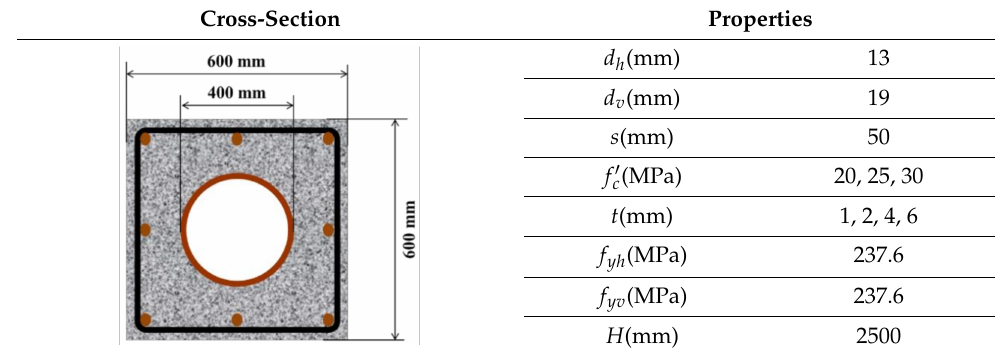
Table 4. Cross-section and specification of the S-C ICH RC column.